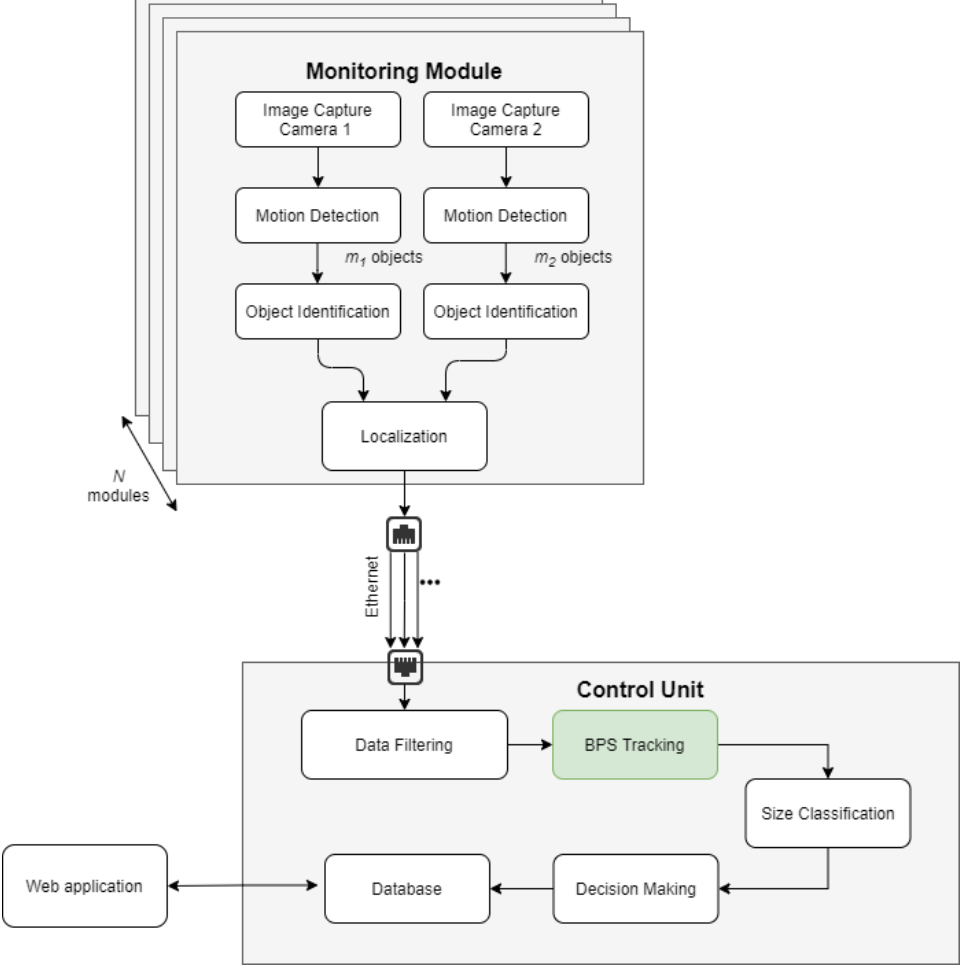
Figure 2. Processing architecture, based